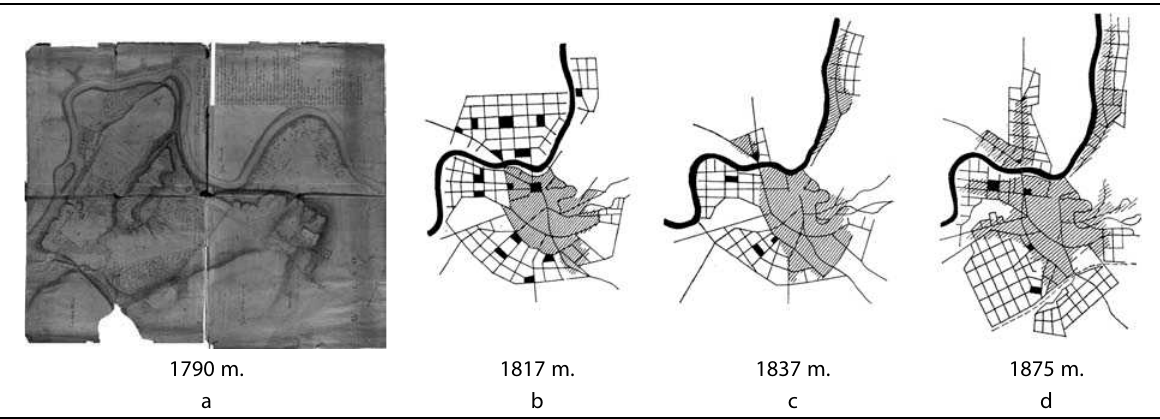
Fig. 1. L. Gucevičius‘ plan of the south-western part of Vilnius in 1790 (a); schemes of Vilnius perspective plans in the 19 th c (b, c,